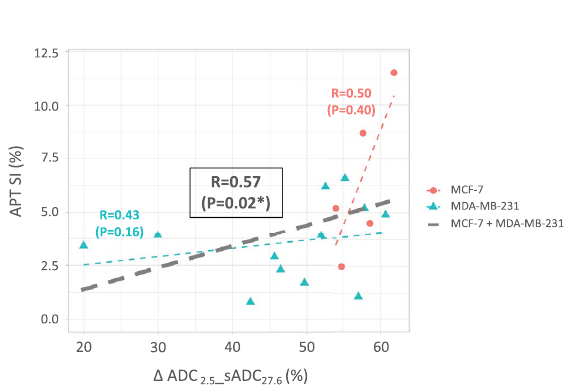
Figure 3. Scatter plots of ΔADC 2.5 _sADC 27.6 against APT SI. The Spearman’s rank correlation coefficients R, the corresponding P values in each tumors are shown in the figure. The black dashed line indicates the relationship between ΔADC 2.5 _sADC 27.6 and APT SI in the entire tumors (mixing MCF-7 and MDA-MB-231 groups).